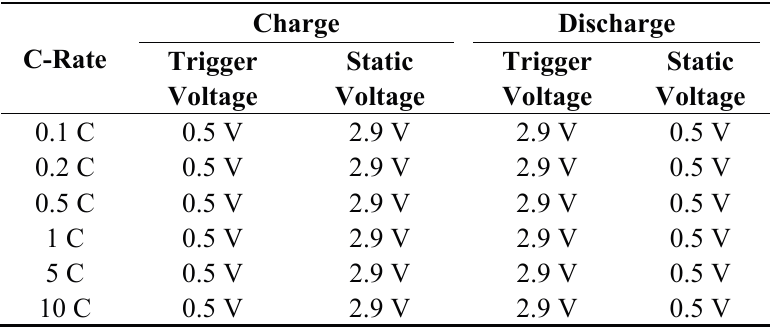
Table 3. Coin cell test process (three cycles at each